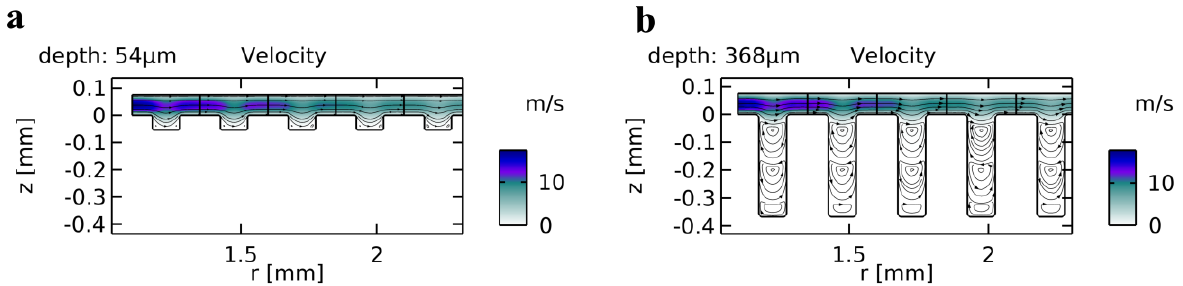
Figure 6. ( a ) Flow field for a trench depth of 54 µm. ( b ) Flow field for a trench depth of 368 µm. Several induced vortices interact with each other, causing shear stress towards themselves, rendering deeper vortices irrelevant for the main leakage flow. The diameter of the vortices depends on the width of the trenches, which here amounts to 100 µm.